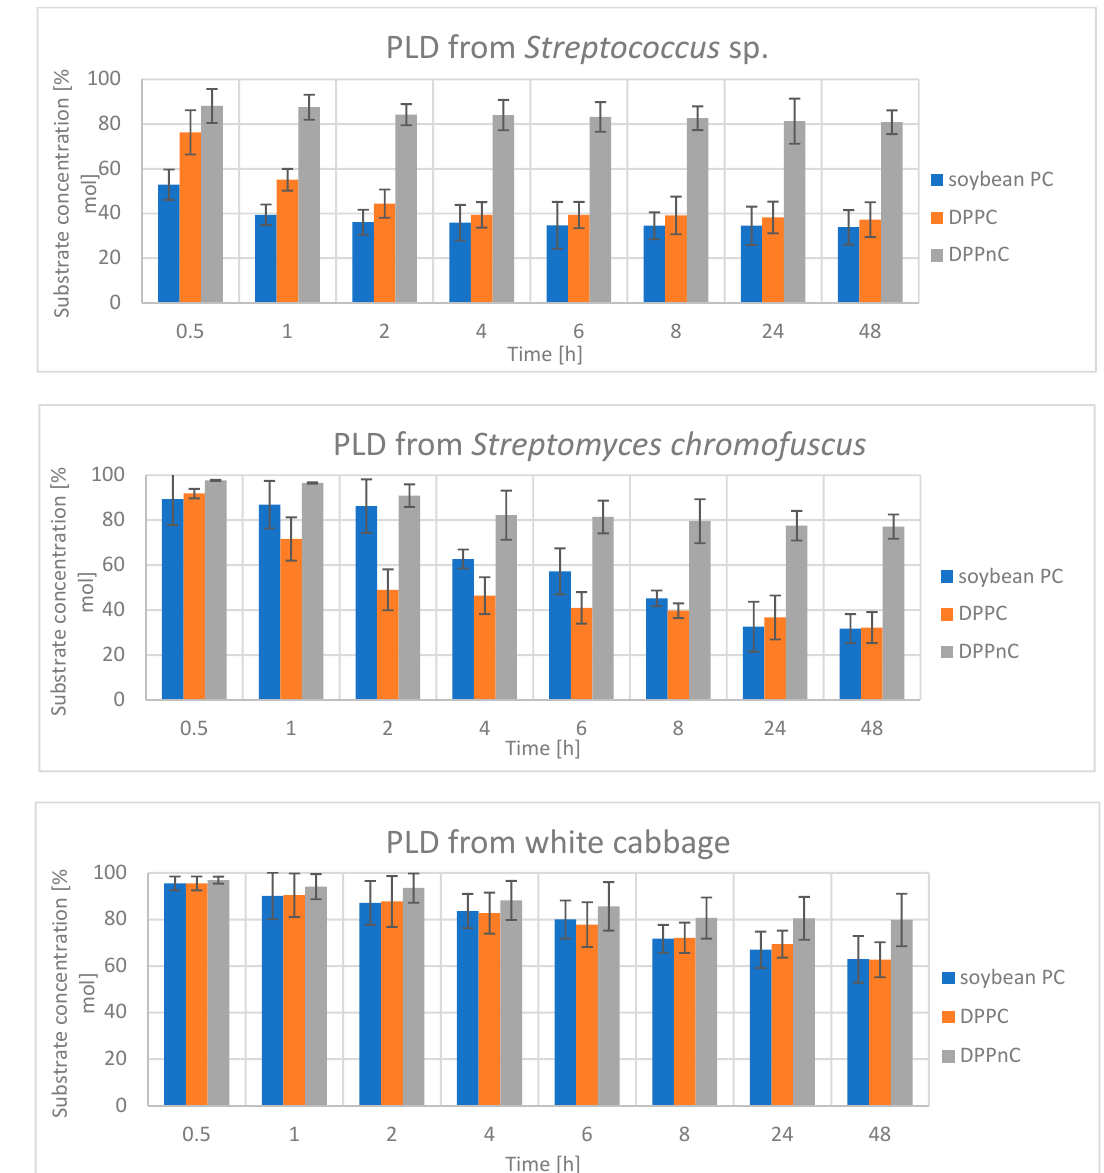
Figure 4. Enzymatic hydrolysis of DPPnC, DPPC and soybean PC by phospholipases D. Results are presented as means ± standard deviation.